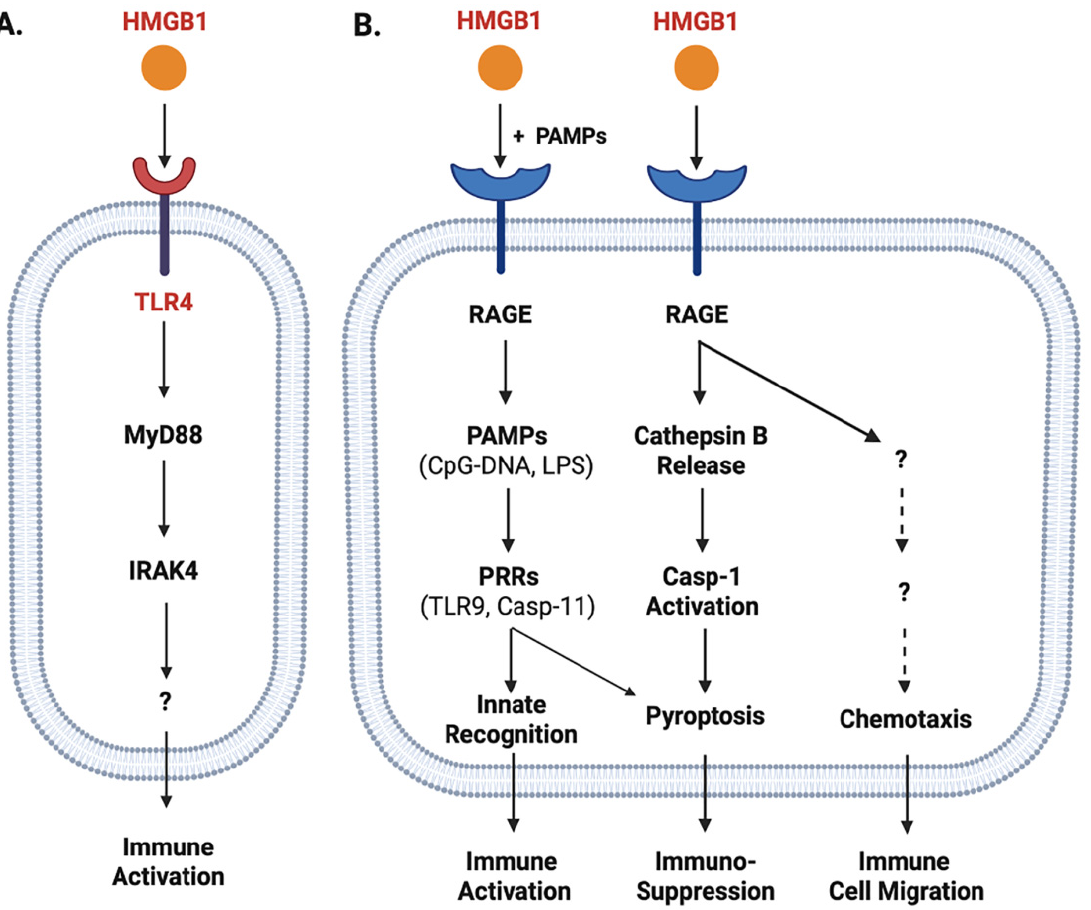
Figure 2. Role of TLR4 and RAGE in the regulation of HMGB1-mediated divergent inflammatory responses. HMGB1 can bind different PRRs such as TLR4 (Panel A ) and RAGE (Panel B ) with different affinities, and consequently induce divergent inflammatory responses such as immune cell migration, immune activation, or pyroptosis and resultant immunosuppression.